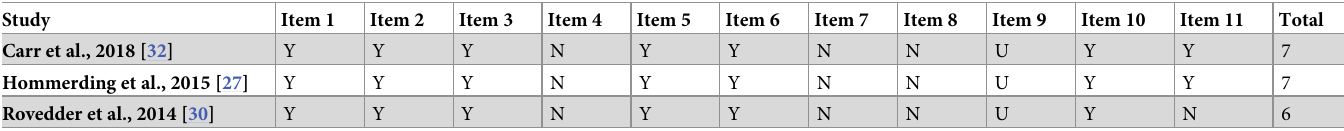
Table 4. CASP Scores for Randomised Control Trials.